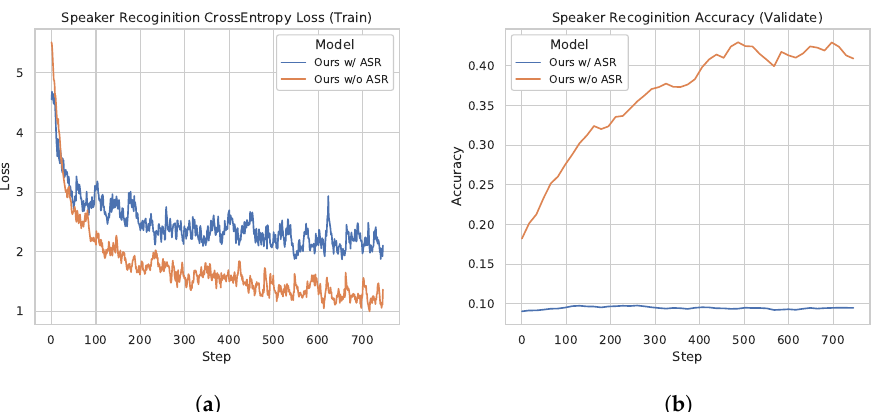
Figure 4. Speaker recognition test. ( a ) Cross-entropy loss curve for the speaker label while training the models with/without the ASR task. ( b ) Speaker recognition accuracy curve on the validation dataset while training the models with/without the ASR task.